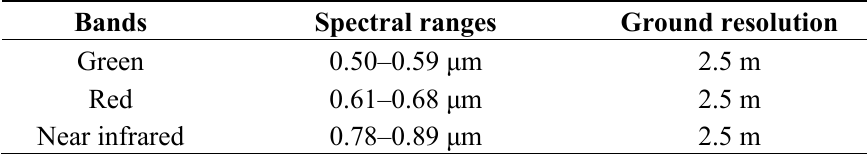
Table 2. Available SPOT 5 image